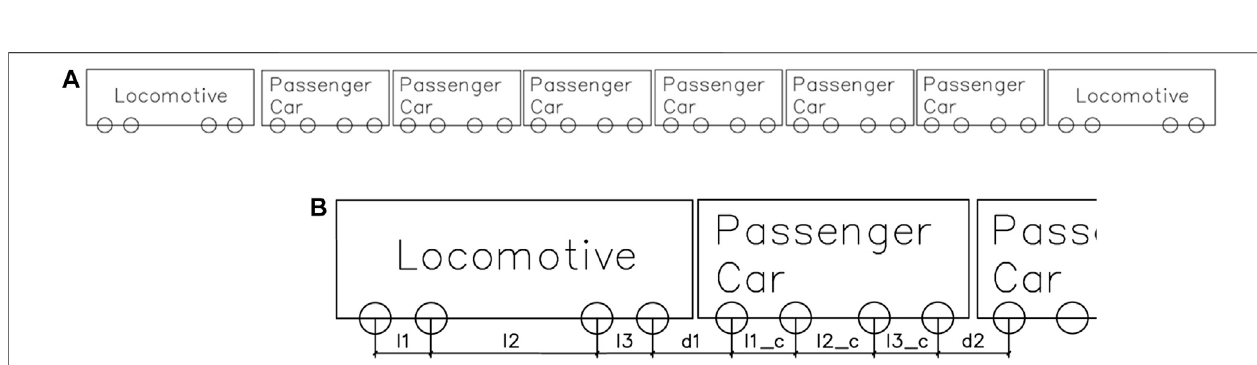
FIGURE4| Schematicrepresentationoftheacelaexpresstrainhighlightingtheaxlespacingsconsideredinthismodel: (A) Layoutoftheentiretrain; (B) Zoomed-In view showing the axle spacings.